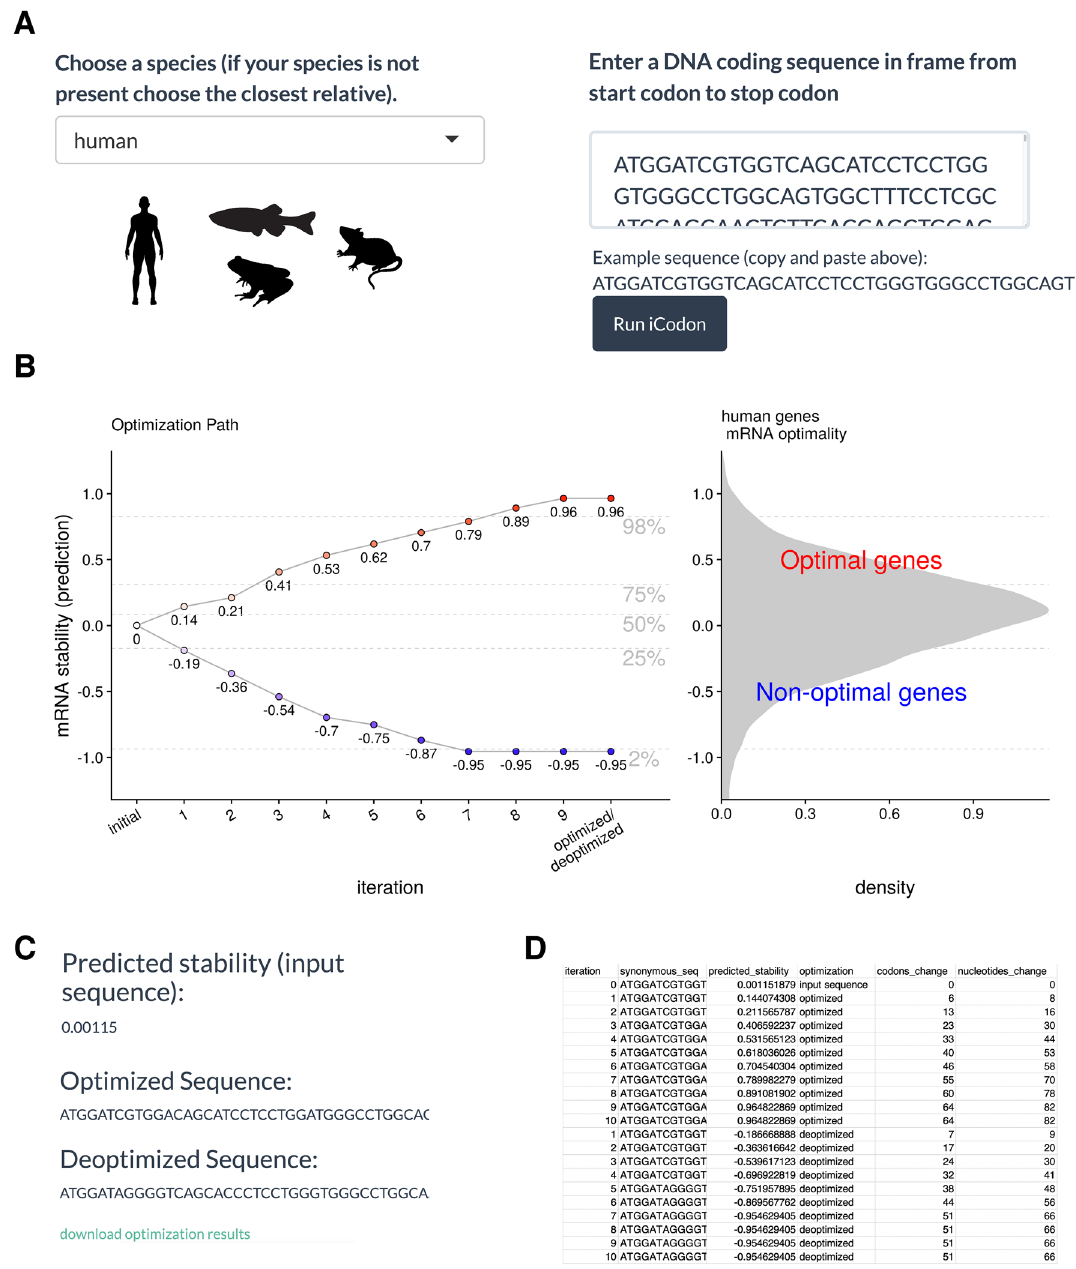
Figure 6. iCodon user steps. ( A ) The user needs to select between four species (human, mouse, zebrafish or Xenopus ). The coding sequence (A, T, G and C) needs to be pasted into the box indicated and the Run iCodon box needs to be clicked. Illustrations by Mark Miller. ( B ) The scatter plot will show the original sequence in grey with its predicted stability. Each of the optimized (red) or deoptimized (blue) sequences with each respective stability score will be displayed. A histogram of the mRNA stability distribution of endogenous genes of the selected species is shown to use as a reference for the designed variants. ( C ) The original sequence, as well as all designed variant sequences, stability scores and nucleotide/codon changes with respect to the original sequence will be provided in a file by clinking “download optimization results”. ( D ) Example table of the downloaded iCodon